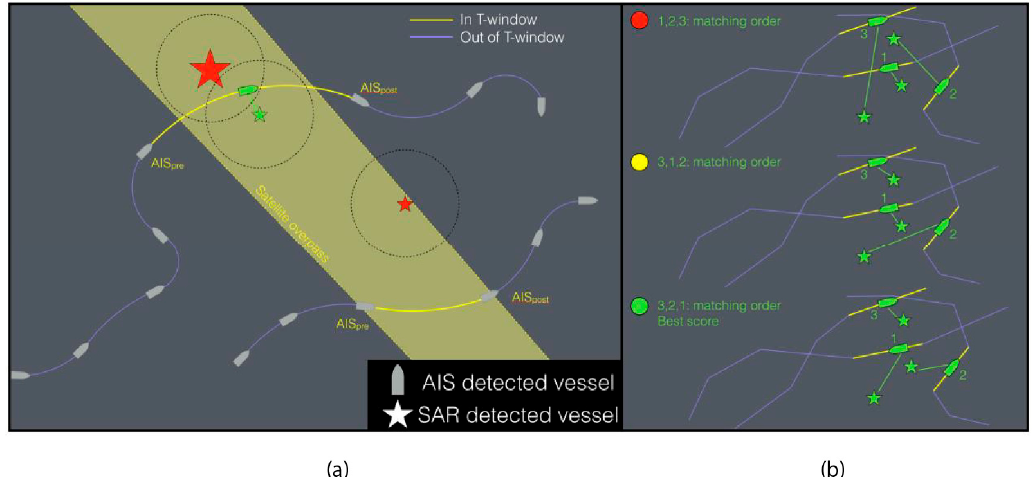
Figure 12. Integration of Earth observation (EO) and AIS vessel track data: ( a ) interpolated vessel tracks (gold lines) for “in T-window” vessels. The satellite swath is shown in yellow; ( b ) vessels detected by EO sensor (star icons) were matched to vessels recorded by AIS (ship icons) based on pre-determined proximity